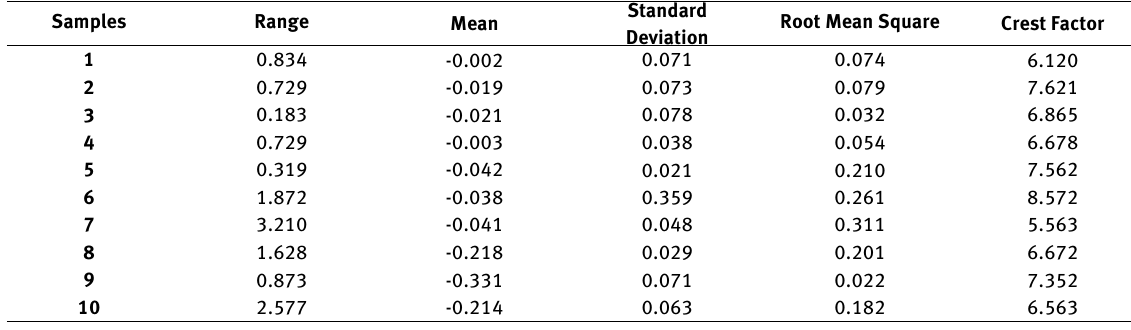
Table 1: Feature extraction of samples